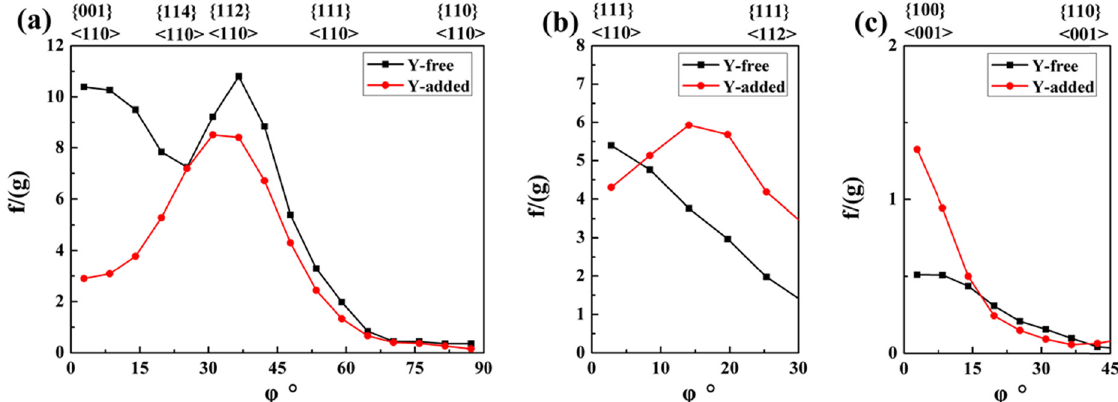
Figure 19: Distribution diagram of orientation lines of two cold - rolled sheets: ( a ) α orientation line; ( b ) γ orientation line; and ( c ) η orientation